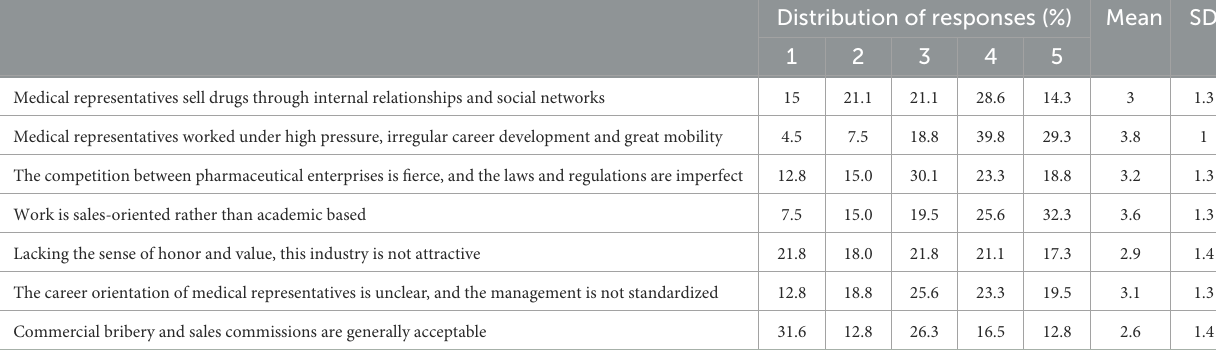
Distribution of responses (%)